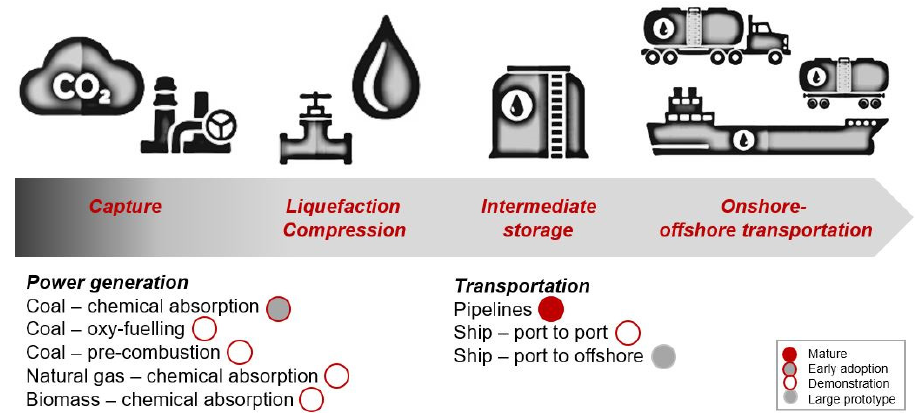
Figure 1. CCS chain. Alternative options and its Technology Readiness Level (adapted from [7]).